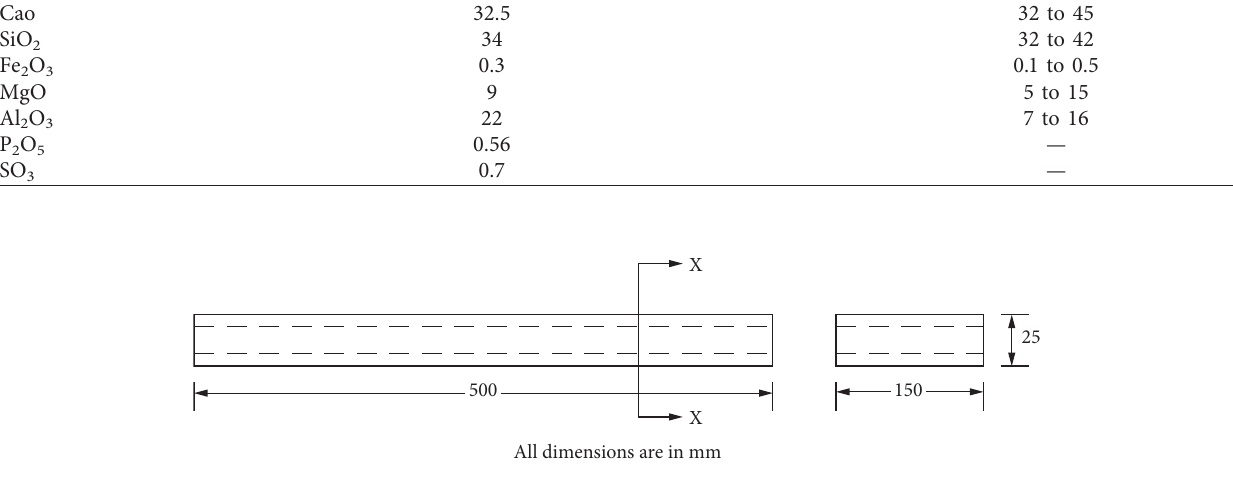
Figure 1: Cross section of the ferrocement laminates. Table 2: Details of test specimen with chicken mesh for flexure